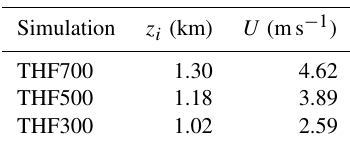
Table 1. Boundary-layer height ( z i ) and the horizontal velocity scale ( U